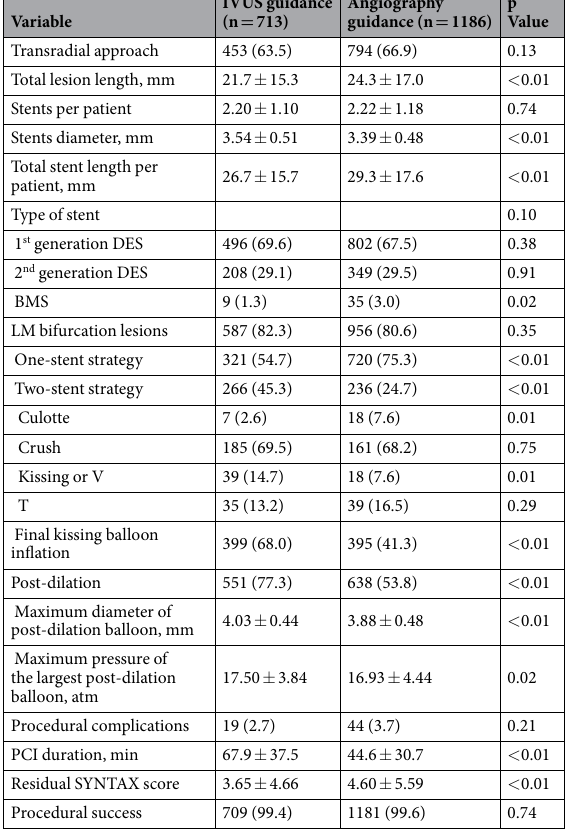
Table 2. Procedural Characteristics. Values are mean ± SD or n (%). BMS = bare metal stent; DES = drug- eluting stent; other abbreviations as in Table